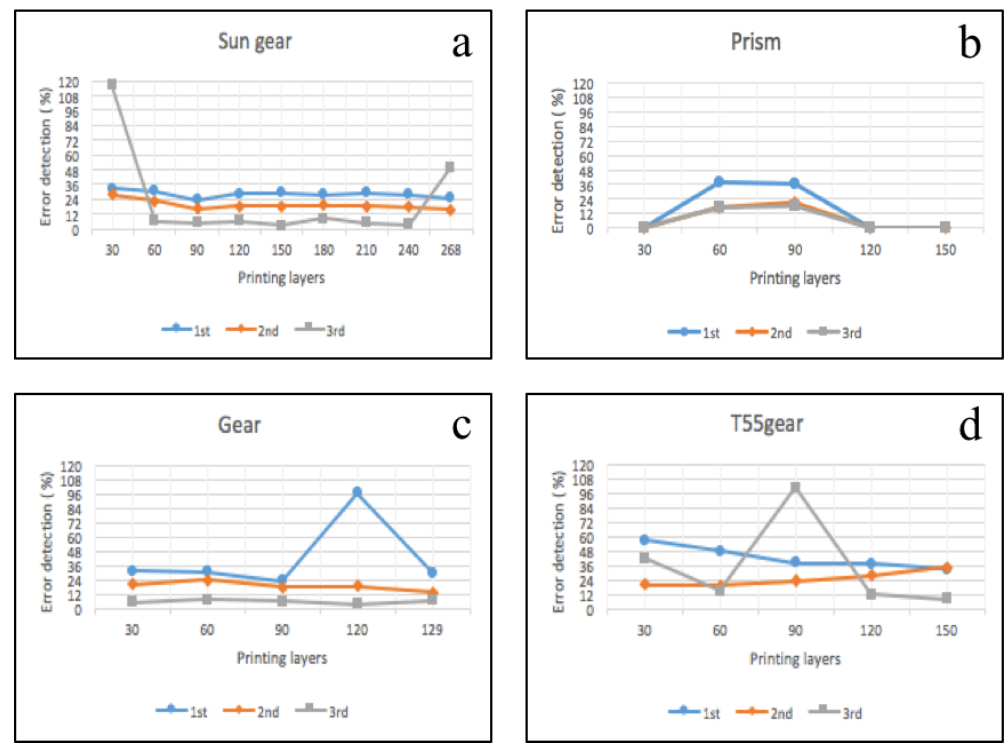
Figure 10. Image pre-processing—SIFT and RANSAC rescale and rectification: the error detection of normal printing state for ( a ) sun gear; ( b ) prism; ( c ) gear; and ( d ) t55gear.